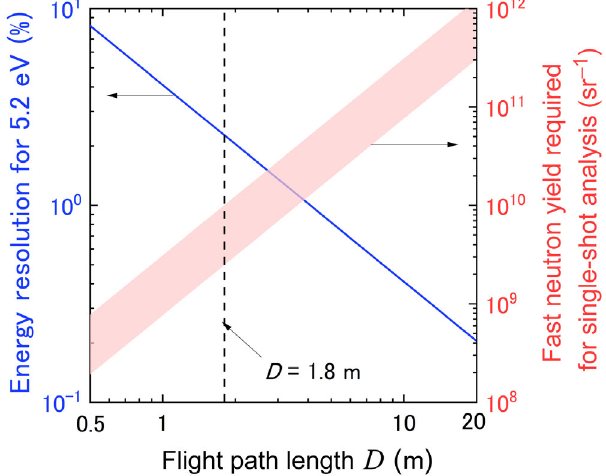
FIG. 7. Blue: energy resolution of NRTA Δ E n =E n at E n ¼ 5 . 2 eV estimated by Eq. (9) as a function of the flight path length D for the configuration of the present moderator. Red: fast neutron yield at the source to achieve the single-shot